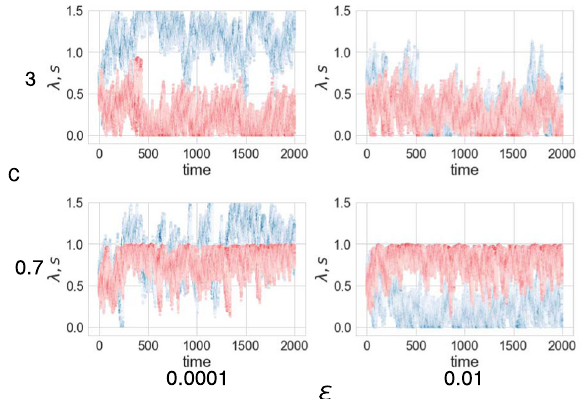
Fig. 2 Time series of family strategy parameters. The temporal evolution of the values of the probability to form extended families s (red) and the inequality in inheritance λ (blue) of families in a society are plotted, for environmental conditions with c = 0.7, 3 and ϵ = 0.0001, 0.01.